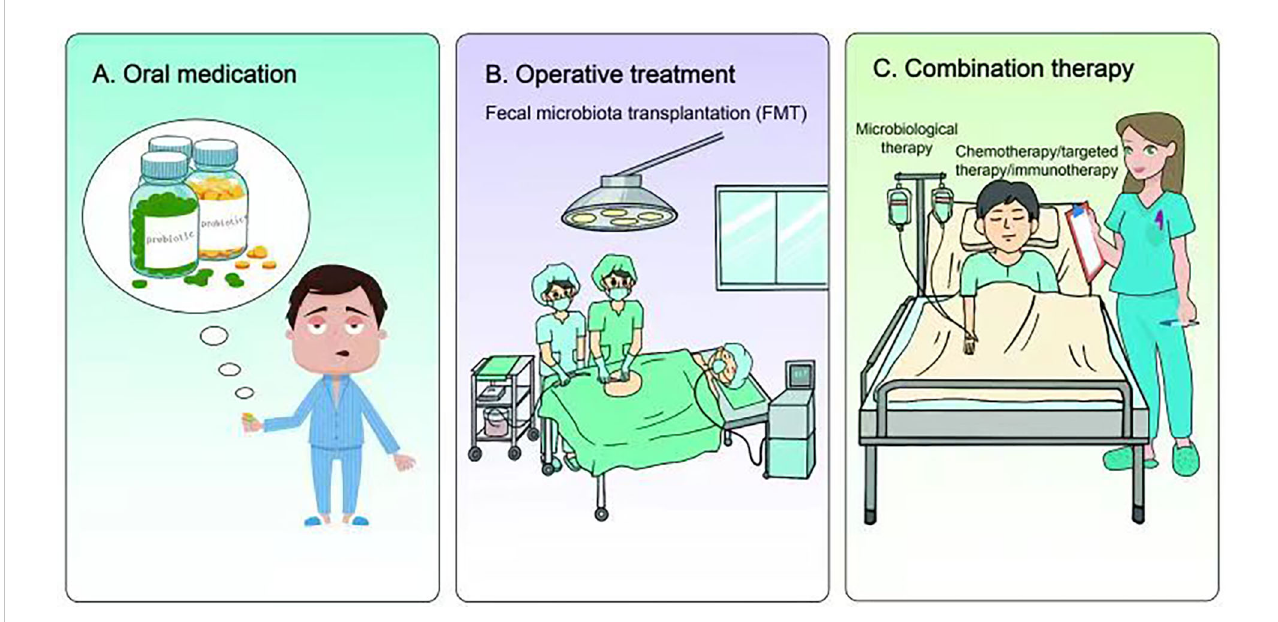
FIGURE 3 Research and application of microbiome in lung cancer treatment. (A) Nutritional intervention with prebiotics and probiotics can not only restore the homeostasis of internal organs or lower airway, but also reduce microbial-induced in fl ammation, genotoxicity and cell proliferation, thus improving the treatment of lung cancer. (B) Fecal microbiota transplantation (FMT) can also restore host homeostasis and reduce microbial-induced in fl ammation. Preclinical studies have shown that FMT therapy may have certain advantages in combating immunotherapy resistance in lung cancer. (C) Chemotherapy, targeted therapy or immunotherapy combined with microbial therapy can improve the clinical treatment effect of lung cancer